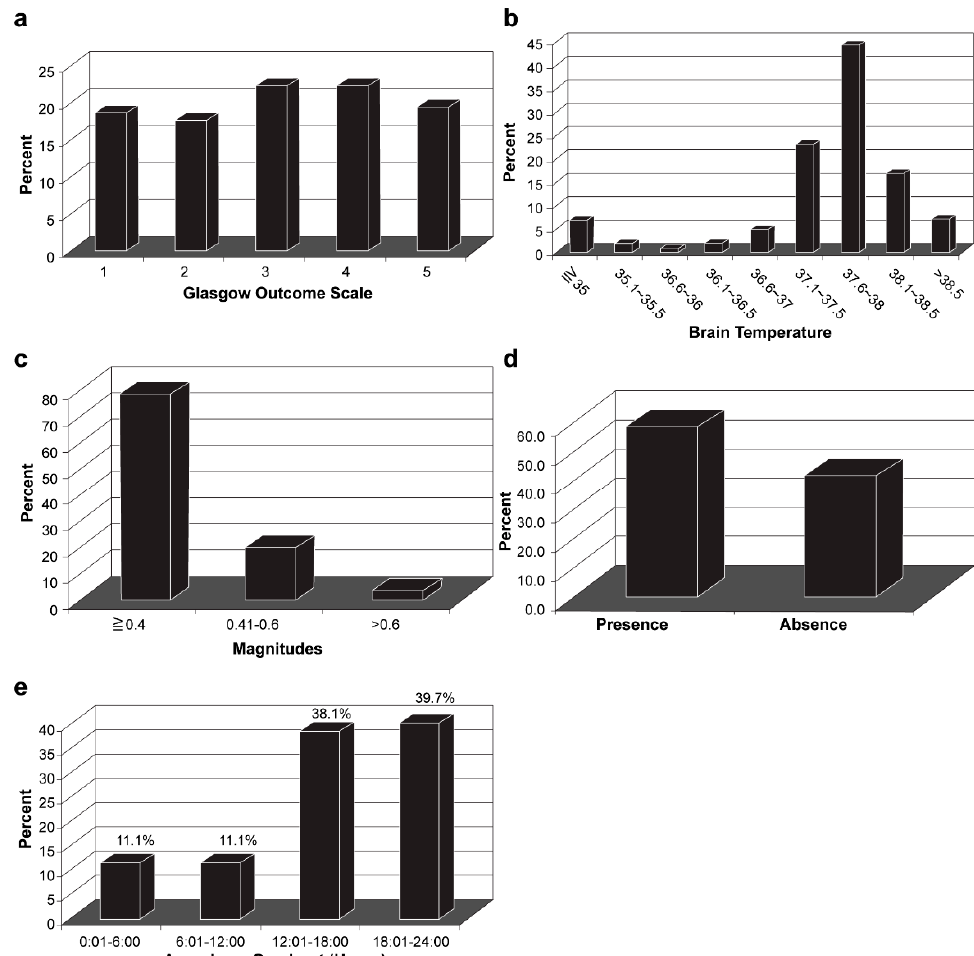
Figure 2. Analysis of brain temperature and functional outcome at 12 months: ( a ) Glasgow Outcome Scale score 12 months after surgery; ( b ) Mesor of brain temperature; ( c ) Amplitude of brain temperature; ( d ) Presence of circadian rhythm of brain temperature; ( e ) Acrophase of brain temperature.